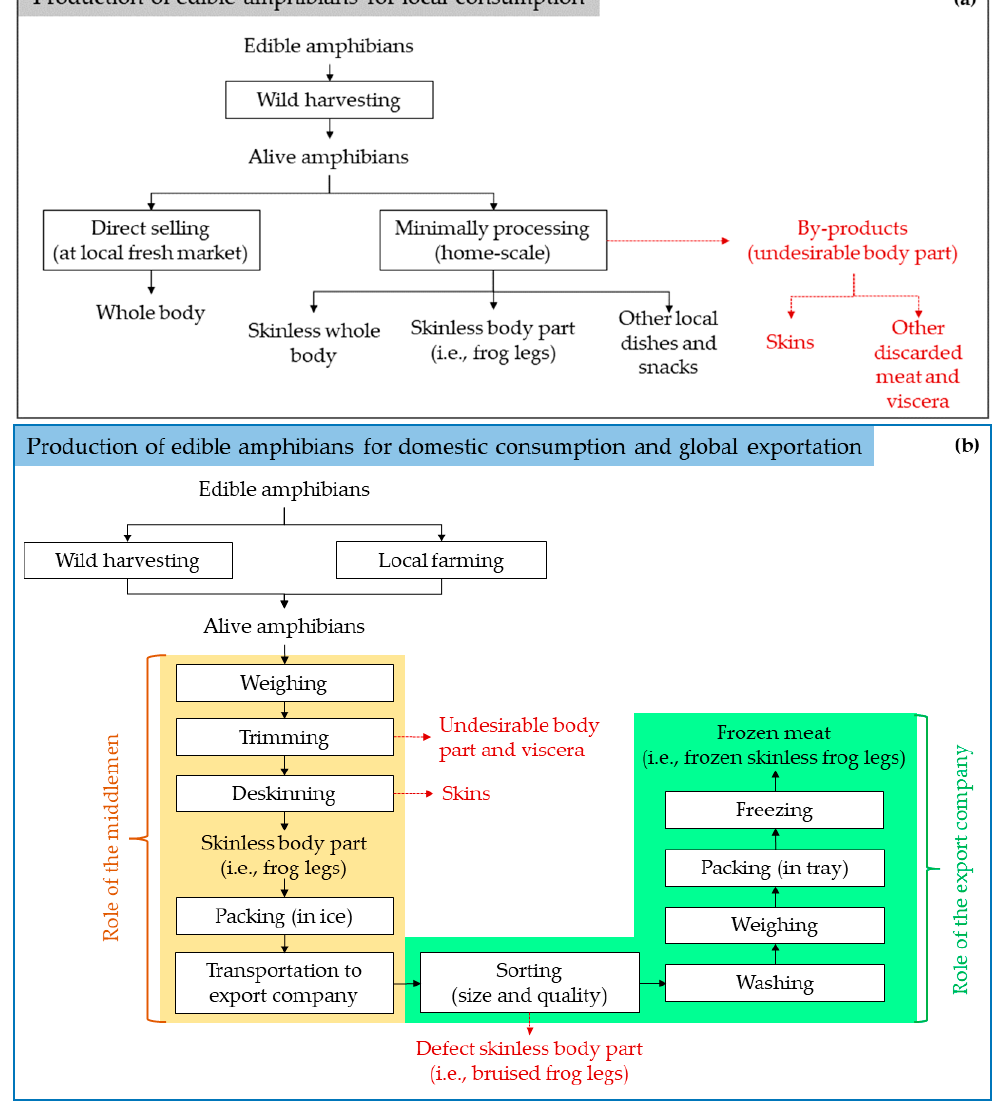
Figure 1. General production schemes of edible amphibians for ( a ) local consumption and ( b ) domestic consumption and global exportation, adapted from Kusrini and Alford [34] and Cunningham, Turvey, Zhou, Meredith, Guan, Liu, Sun, Wang, and Wu [30]. Onadeko, Egonmwan, and Saliu [36] identified the predominant edible frog species in Nigeria as Hildebrandtia ornate , Hoplobatracus occipitalis , Ptychadena pumilio , and Pyxicephalus edulis. For non-consumptive utilization (such as medicinal and mythic purposes), Bufo pentoni , Ptychadena mascareniensis , Tomoptera cryptotis , and Amietophyrynus regularis have been used. The high annual demand in Nigeria has kept up with the large supply quantities where the excessive supply can be exported. In Indonesia, especially on Java Island, Crab-eating frog ( Fejervarya cancrivora ), Giant javan frog ( Limnonected macrodon ), and Grass frog ( F. limnocharis ), have been reported to contribute to 75.4%, 18.8%, and 5.8% of the total catch, respectively. Based on the Foreign Trade Statistical Bulletin by the Indonesian Statistical Bureau, a fluctuating trend of the export of frogs’ legs was observed from 1969 to 2002 [34]. Gratwicke, Evans, Jenkins, Kusrini, Moore, Sevin, and Wildt [35] reported that Indonesia contributed around half of the global frog leg trade, accounting for USD 40 million where France, Belgium, and the USA were the predominant importers (75%). Unfortunately, no further update has been found since. Belgium, Luxembourg, France, the